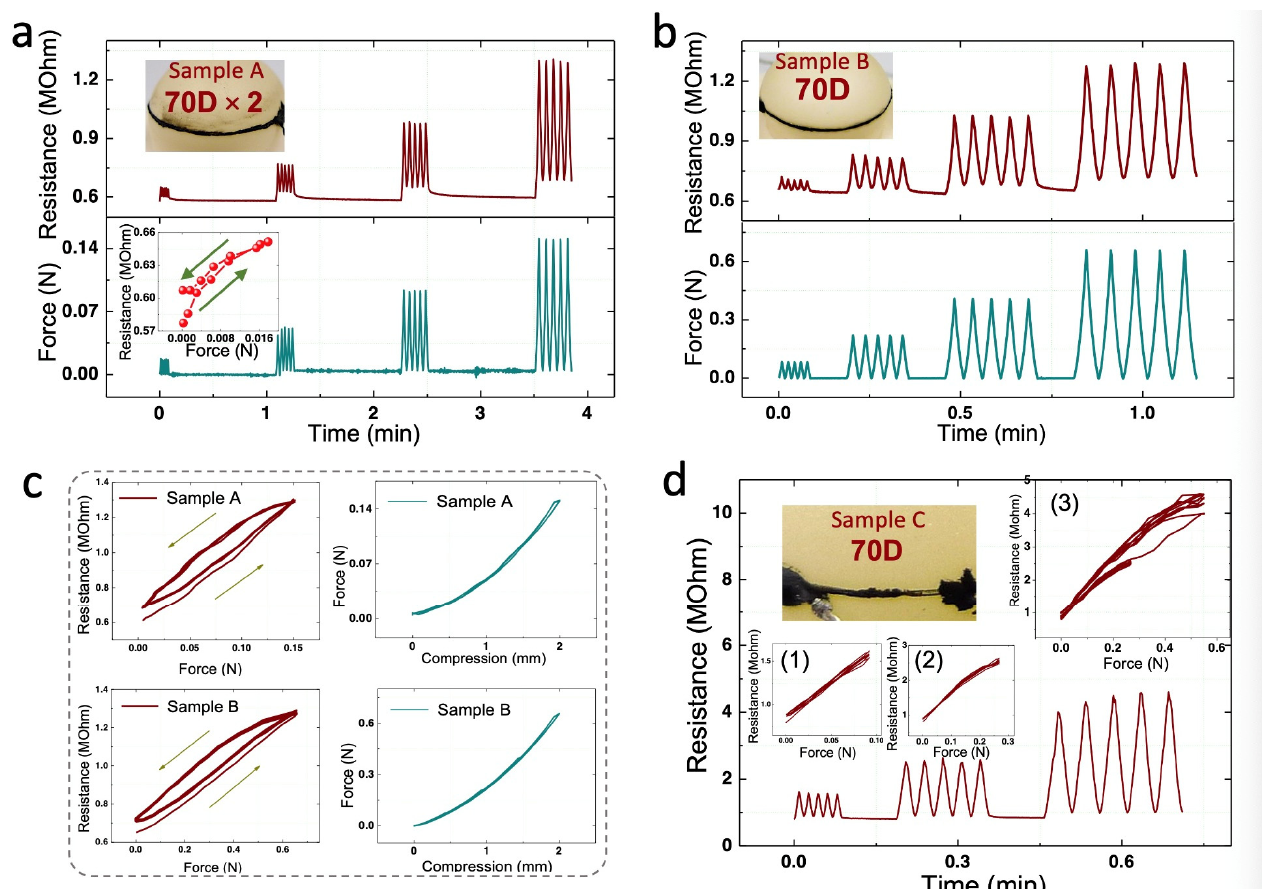
Figure 4. ( a )Typical force and resistance curves of pressure sensor sample A under cyclic compression. The strain gauge, as pictured in the upper inset, was printed using 70D × 2 yarns. Lower inset is the force-resistance curve of the first 0.5 mm compressive cycle. ( b ) The force and resistance curves in cyclic compression tests. Inset is a picture of the sample B. Strain gauge on this sensor was printed using a 70D yarn. ( c ) Electrical and mechanical curves of A and B in the 2 mm compressions. ( d ) Resistance change of pressure sensor sample C. There were major defects on the gauge. (1) and (2) are force-resistance curves in the 0.5 mm and 1.0 mm cyclic compressions, respectively. (3) Force-resistance curves in 0.5 mm, 1.0 mm, and 1.5 mm cyclic compressions. The maximum force of 0.6 N corresponds to a pressure around 7 kPa.